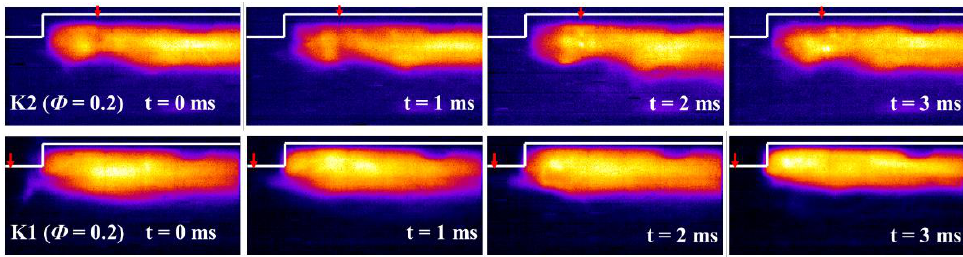
Figure 8. The temporal variation of flame chemiluminescence in K1 and K2 injector cases, Φ = 0.2.